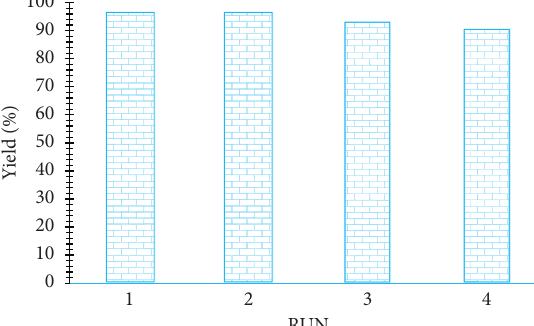
Figure 1: Reusability diagram of MMT-[(CH